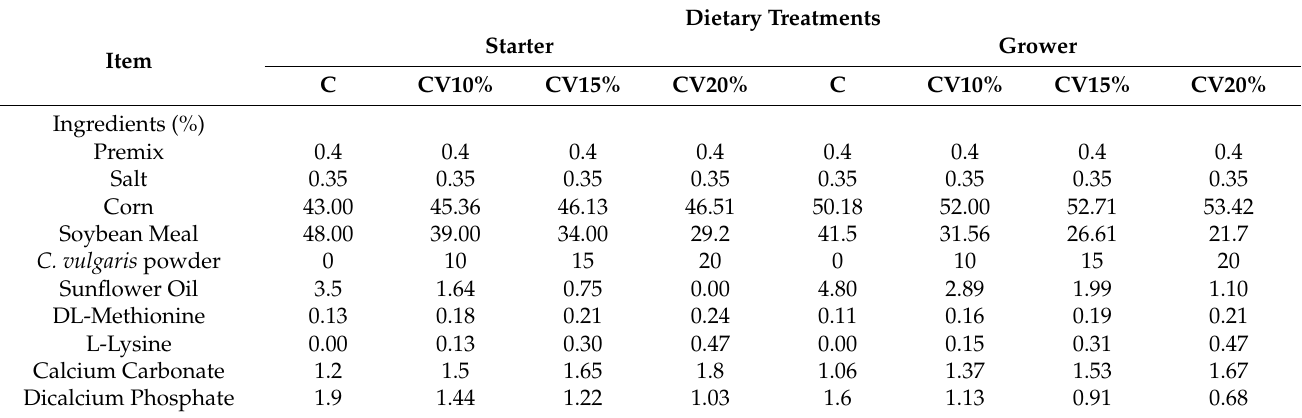
Table 2. Ingredient composition and nutrient levels of experimental diets (%). Dietary Treatments